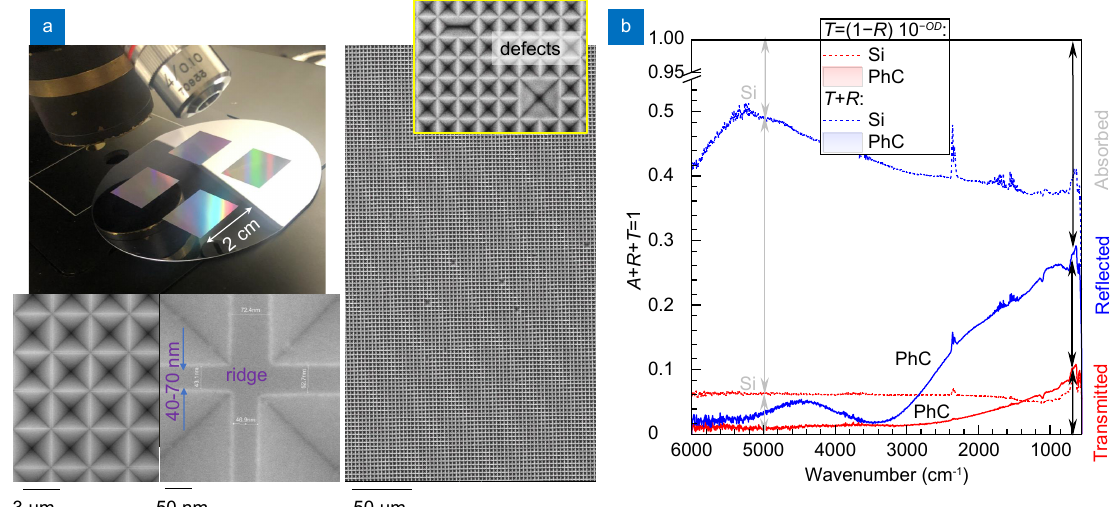
Fig. 6 | ( a ) Photo of large 2 × 2 cm 2 light trapping PhC patterns KOH etched through a chromium-mask defined by EBL; period Λ = 3.1 μm. SEM images of the final PhC pattern on 500-μm-thick n-type Si(100) wafer. ( b ) Color-coded presentation of portions of the absorbed A , reflected, R (measured) and transmitted T = (1 − R )10 −OD (measured) light at different wavelengths from 1.67 to 25 μm (or 6000–400 cm –1 in wavenumbers = 1/ λ ).